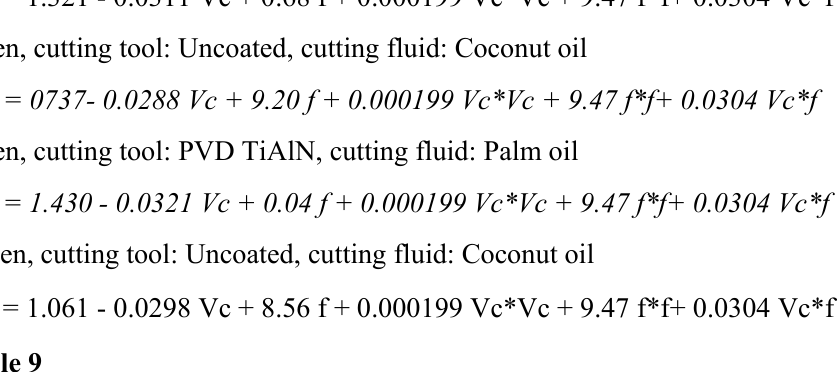
When, cutting tool: Uncoated, cutting fluid: Coconut oil